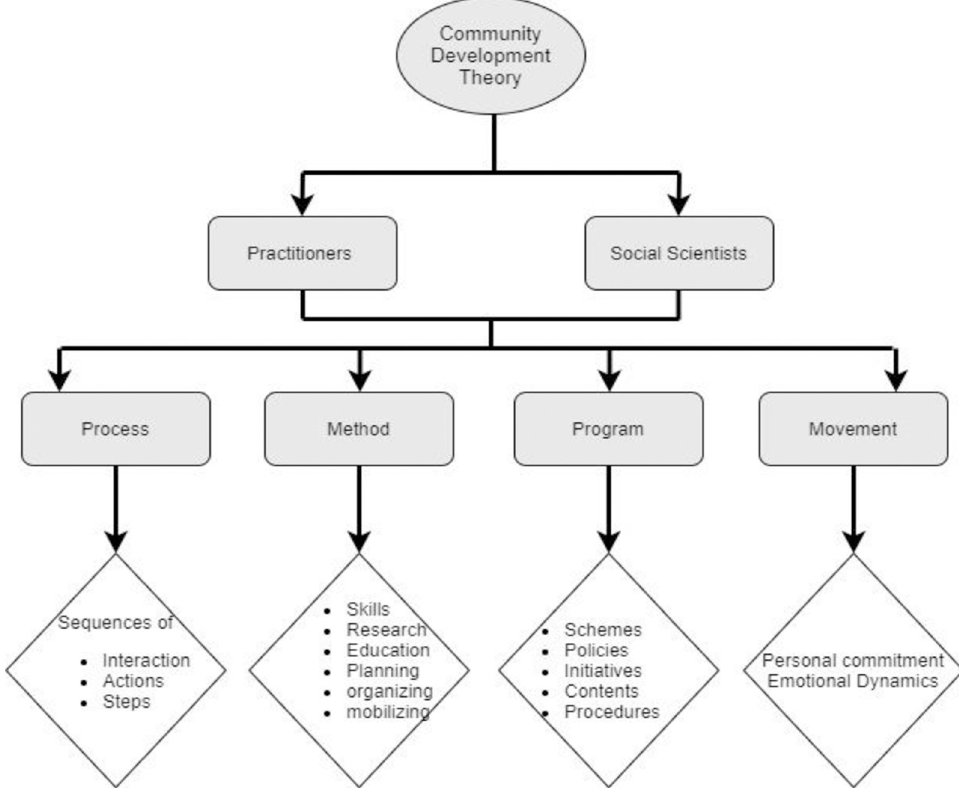
Fig 1. Theory of community development